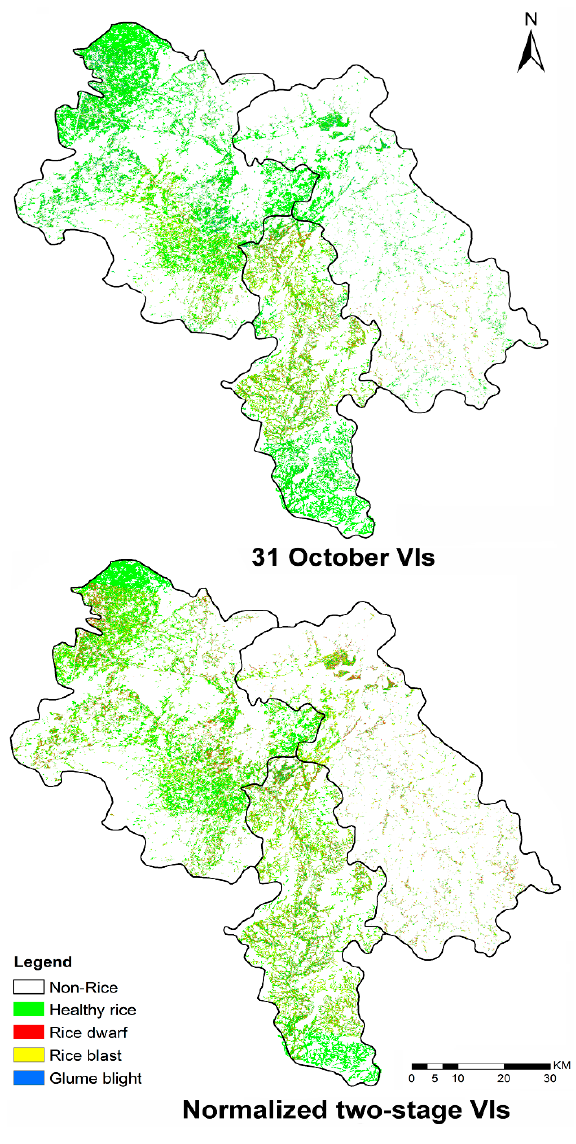
Figure 4. A map of healthy and diseased rice based on the PLS-DA classifier from normalized two-stage and single-date VIs.